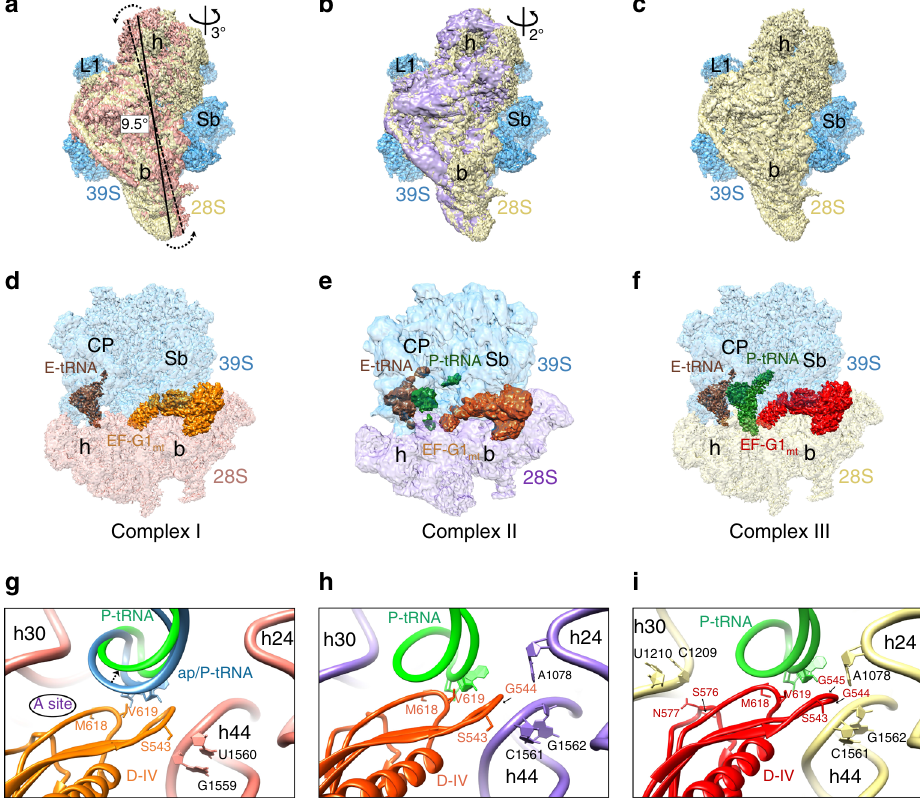
Fig. 3 Conformational states of the 28S subunit and interactions of domain IV of EF-G1 mt in 55S·EF-G1 mt ·GMPPCP complexes. a – c Intersubunit rotation and the 28S head swiveling. a Superimposition of the cryo-EM maps of the Class I and the Class III complexes revealed an overall 9.5° rotation of the 28S subunit (salmon) in an anti-clockwise direction relative to the 39S subunit (blue) in Class I complex, with an additional rotation of the 28S head domain by ~3° in a roughly orthogonal direction to the direction of the inter-subunit rotation. b Similar comparison between the Class II and Class III complexes revealed ~2° rotation of the 28S head in the Class II complex (light purple), without a measurable overall inter-subunit rotation. In all three panels, the 55S mitoribosome is shown from the 28S solvent side. The 28S subunit from Complexes I and II are shown in salmon and purple colors, whereas that from the Class III complex is shown in yellow color. Landmarks for both mitoribosomal subunits in panels a – f are the same as introduced in Fig. 1, except for L1 stalk (L1). d – f Segmented densities corresponding to P- (green) and E- (dark brown) site tRNAs mt and EF-G1 mt (orange, reddish orange, and red) in complexes I – III are shown, with semitransparent densities for the 28S (bottom) and 39S (top) subunits. g – i Interactions of EF-G1 mt domain IV with the 28S subunit and the P-site tRNA. g In the Class I complex, domain IV (orange) is positioned ~10 Å away from the 12S SSU rRNA helices (salmon) h30 and h24. A 6 – 7 Å shift in the anticodon end of P-tRNA (green) to an ap/P hybrid position (blue) is required to establish contacts with the EF-G1 mt domain IV (orange). The A-site location is indicated. h Intermediate head swiveled-only state shows limited interactions of domain IV (reddish orange) with the 12S rRNA helices (light purple) h24 and h44. i Multiple interactions of domain IV (red) with the 12S rRNA (yellow) and P-site tRNA (green) in the Class III